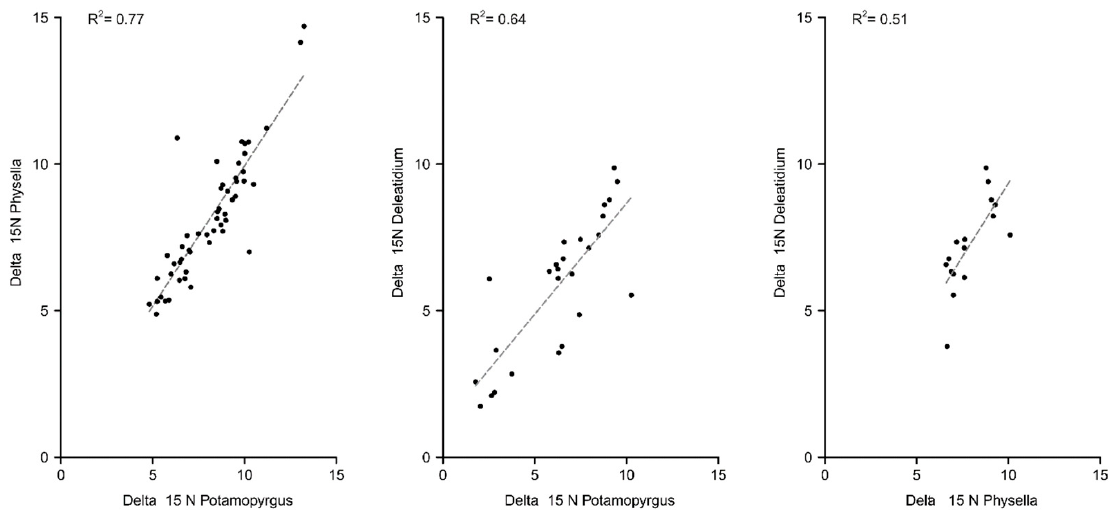
Figure 3. Comparison of primary consumers δ 15 N ratios at stream sites where more than one grazer taxon occurred. The fitted linear regressions between taxa δ 15 N values are represented by the dashed lines and the strength of the relationships by the R 2 values.